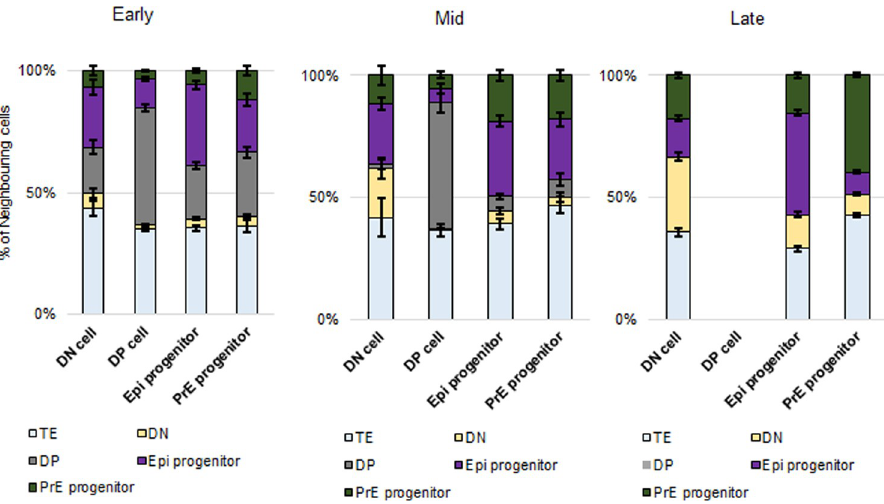
Fig 2. Neighbour composition analysis indicates clustering of Epi progenitor cells and DP cells (data I). The proportion of neighbouring cells of one of the five populations TE, DN, DP, Epi progenitor and PrE progenitor are displayed for DN, DP, Epi progenitor and PrE progenitor cells in in early (left panel), mid (centre) and late (right) embryos for data I. Error bars indicate the standard errors of the means. See S4 Fig for the statistical z-test results. Details on the number of embryos and cells analysed are in S1 and S2